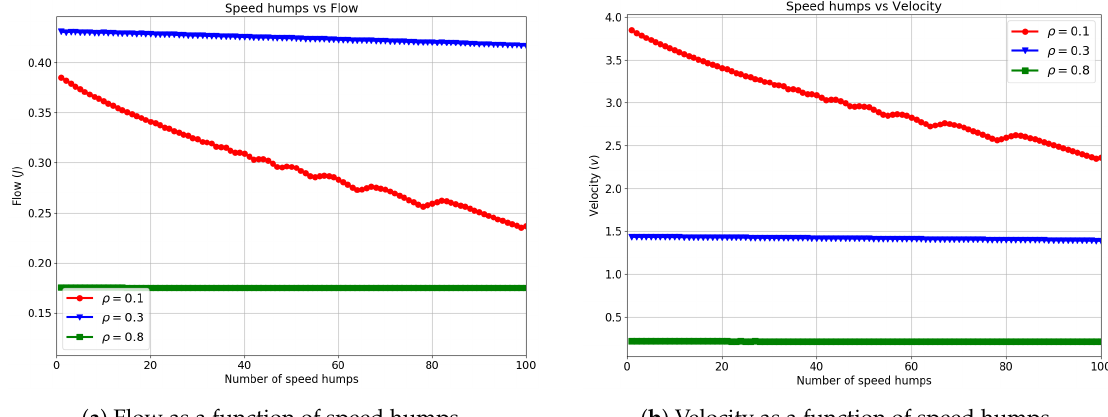
Figure 5. Flow and velocity as a function of speed humps. The flow is given as the average number of vehicles passing through a cell per simulation step, and the velocity indicates the average number of cells to move forward per simulation step.